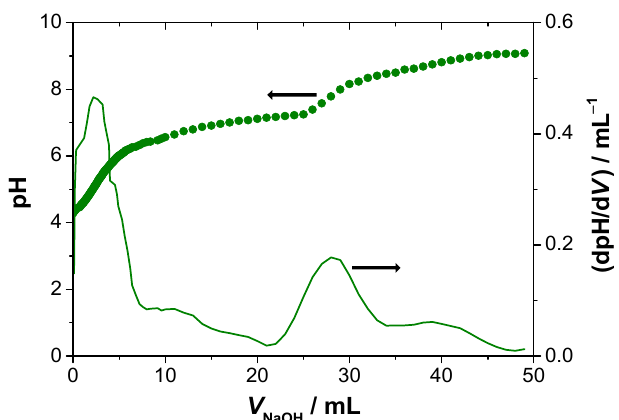
Figure 4. Titration curve (dots) and respective derivative (solid line) of a suspension of T-POP3 (15.2 mg) with a NaOH solution 0.584 mM. The arrows indicate the corresponding ordinate axis.